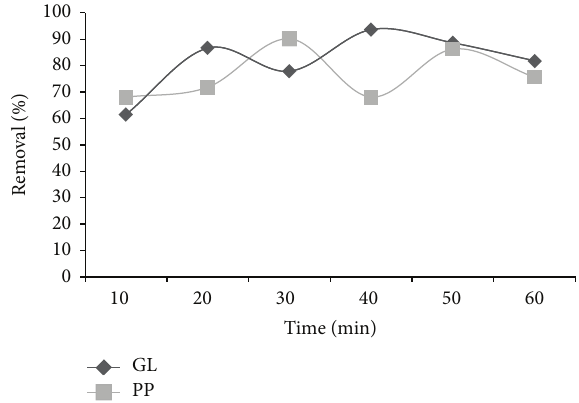
Figure 14: Langmuir isotherm